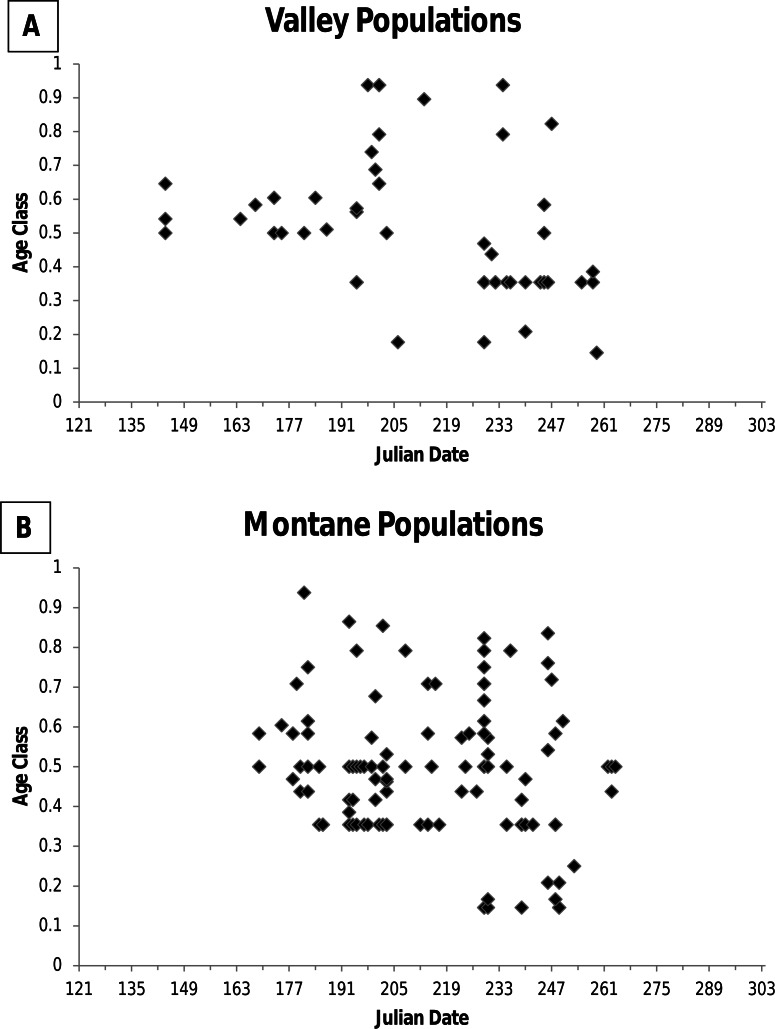
Figure of age class of jumping mouse specimens by date of capture.Age class of specimens of the New Mexico meadow jumping mouse (Zapus hudsonius luteus) by date of capture for (A) valley populations and (B) montane populations. Age class was determined by characteristics of the skull and dentition.